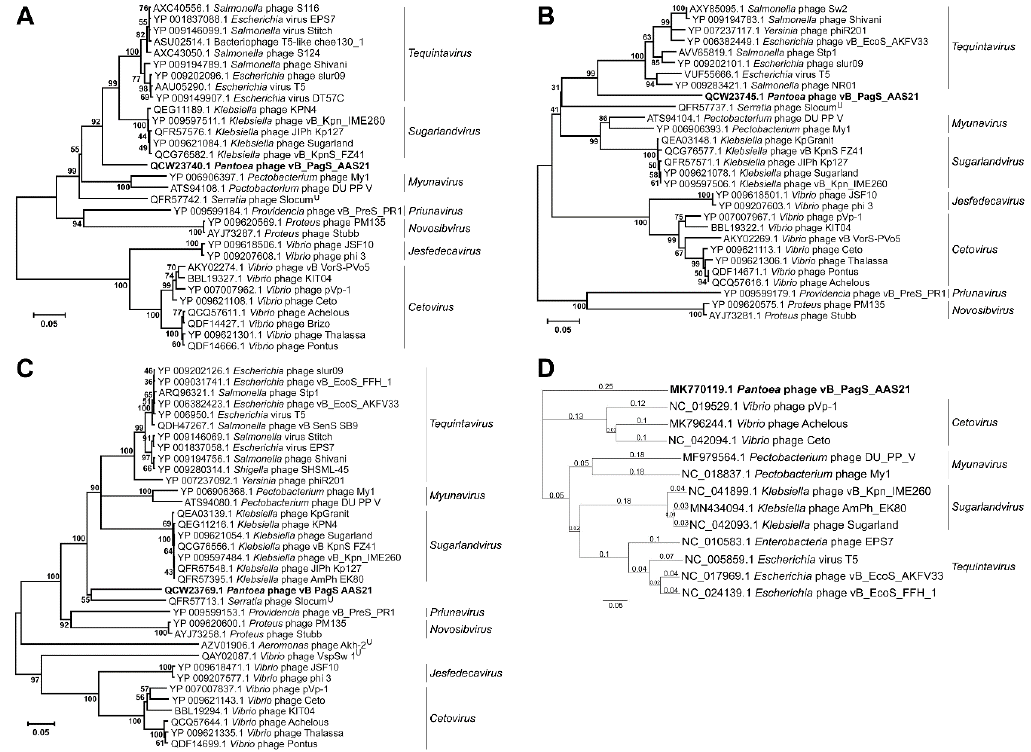
Figure 3. Neighbor-joining tree analysis based on the alignment of the amino acid sequences of: ( A ) Terminase large subunit, ( B ) major capsid protein, and ( C ) DNA polymerase. Phylogenetic analysis was conducted using MEGA version 7. The percentage of replicate trees in which the associated taxa